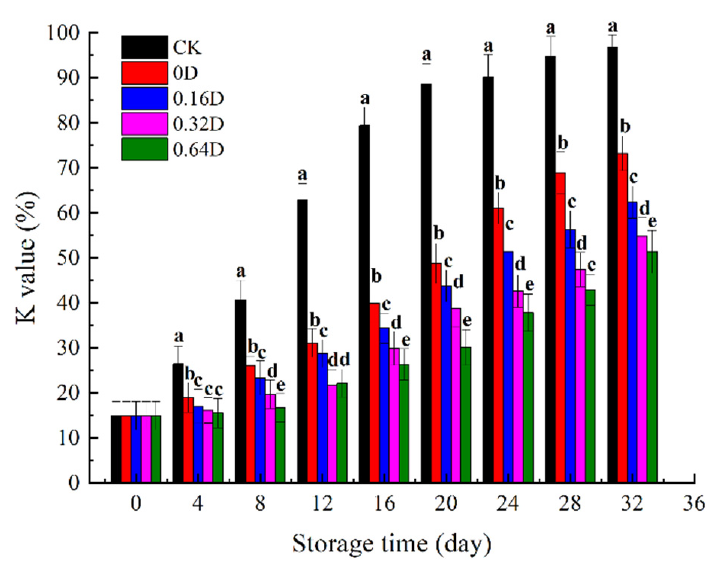
Figure 6. Changes in the K value of turbots during refrigerated storage. Different superscript letters a–e indicate significant differences ( p < 0.05) .